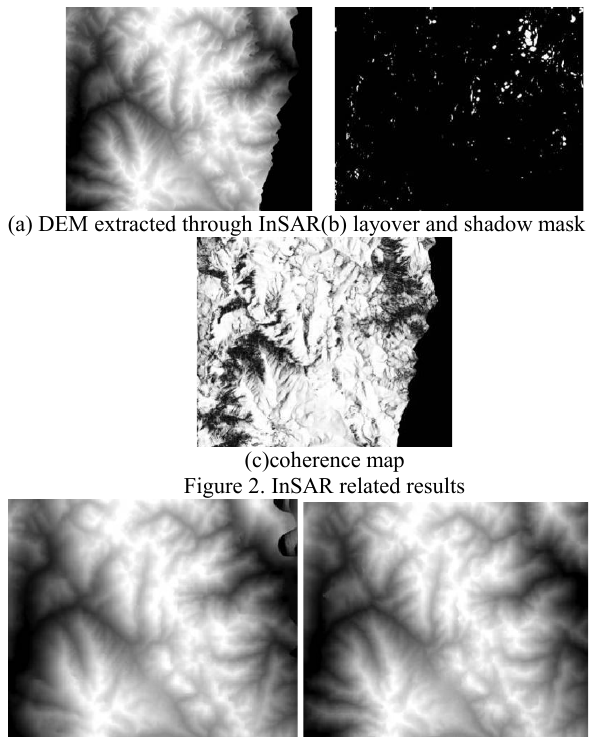
Figure 3. StereoSAR related results